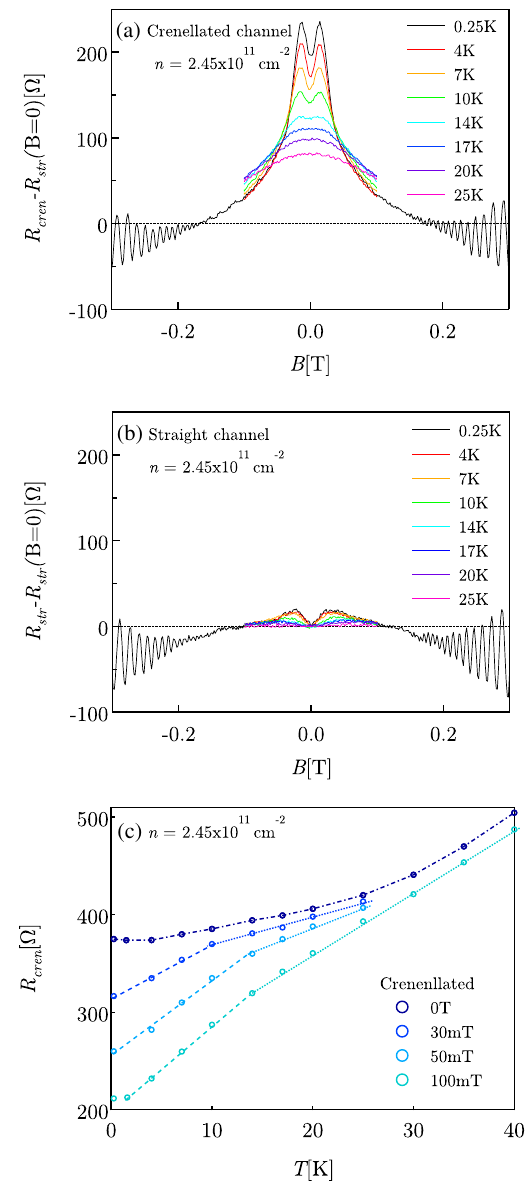
FIG. 10. Magnetoresistance of (a) the crenellated channel after removing the zero-field resistance of the straight channel ð B ¼ 0 Þ and (b) the straight channel after removing R straight ð B ¼ 0 Þ at n ¼ 2 . 45 × 10 11 cm − 2 for different temper- R straight atures. (c) Resistance of the crenellated channel as a function of the temperature at different magnetic fields. Dashed (dotted) lines are straight line guides for low (high) temperatures depicting the change in